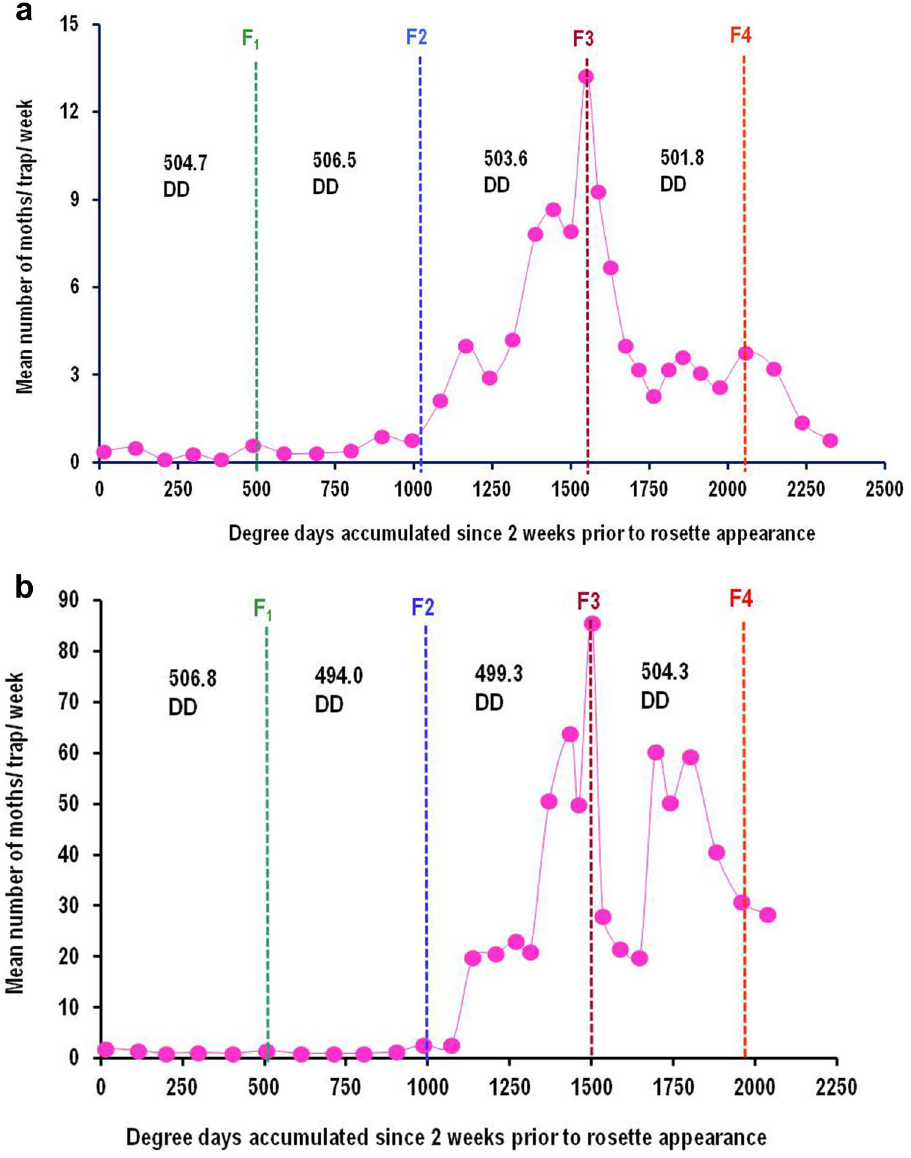
Figure 4. Generation events estimated for pink bollworm based on degree-day accumulations between successive moth catch peaks recorded in sex pheromone traps at Nagpur (India). When moth catches were plotted against DD accumulations, the number of DD required for completing one generation remained fairly constant in a range between 501.8–506.5 during 2018–19 (Fig. 5a), and 494.0–506.8 during 2019–20 (Fig.